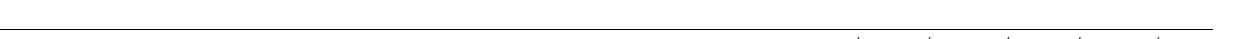
Fig. 4 PLC γ 1/PLC γ 2 double de fi ciency alters gene expression in CLPs and B cell progenitors. BM from Plcg1 + / + Plcg2 + / + , Plcg1 − / − Plcg2 + / + , Plcg1 + / + Plcg2 − / − , or Plcg1 − / − Plcg2 − / − mice were transplanted into lethally irradiated congenic wild-type CD45.1 + mice. Six to eight weeks after transplantation, CLPs (CD45.2 + Lin − IL-7R + ) and B cell progenitors (CD45.2 + B220 + IgM − IL-7R + ) were sorted from the BM transplantation recipients and subjected to RNA-seq analysis. a Differentially expressed genes in Plcg1 − / − Plcg2 − / − (upper), Plcg1 − / − Plcg2 + / + (middle), or Plcg1 + / + Plcg2 − / − (lower) relative to Plcg1 + / + Plcg2 + / + CLPs. Differentially expressed genes with log2 fold-change ≥ 0.5 and FDR ≤ 0.05 are shown in red. b Heat maps of differentially expressed genes related to T and B lymphocytes in Plcg1 − / − Plcg2 − / − relative to Plcg1 + / + Plcg2 + / + CLPs. c Differentially expressed genes in Plcg1 − / − Plcg2 − / − (upper), Plcg1 − / − Plcg2 + / + (middle), or Plcg1 + / + Plcg2 − / − (lower) relative to Plcg1 + / + Plcg2 + / + B cell progenitors. Differentially expressed genes with log2 fold-change ≥ 0.5 and FDR ≤ 0.05 are shown in red. Heat maps of differentially expressed genes related to B cell lineage ( d ), IL-7 signaling ( e ), cell cycle ( f ), and cell apoptosis ( g )